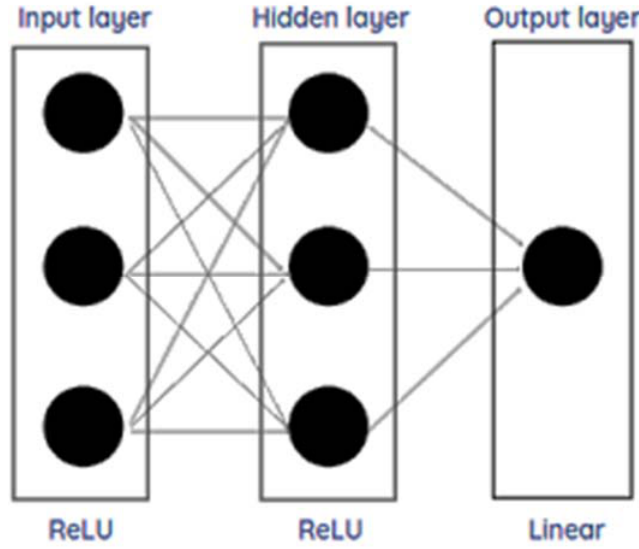
Figure 5. Artificial Neural Network architecture simplified scheme.